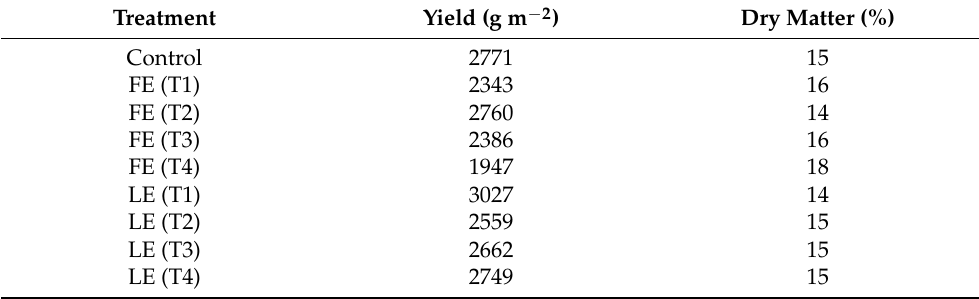
Table 1. Yield and dry matter (%) of rocket plants treated with water (Control) and with borage extracts (flowers extract = FE or leaves extract = LE) obtained with different maceration times: 1 day (T1), 3 days (T2), 7 days (T3), and 14 days (T4). Yield was measured for one tank of each condition at the end of the experiment by cutting plants at